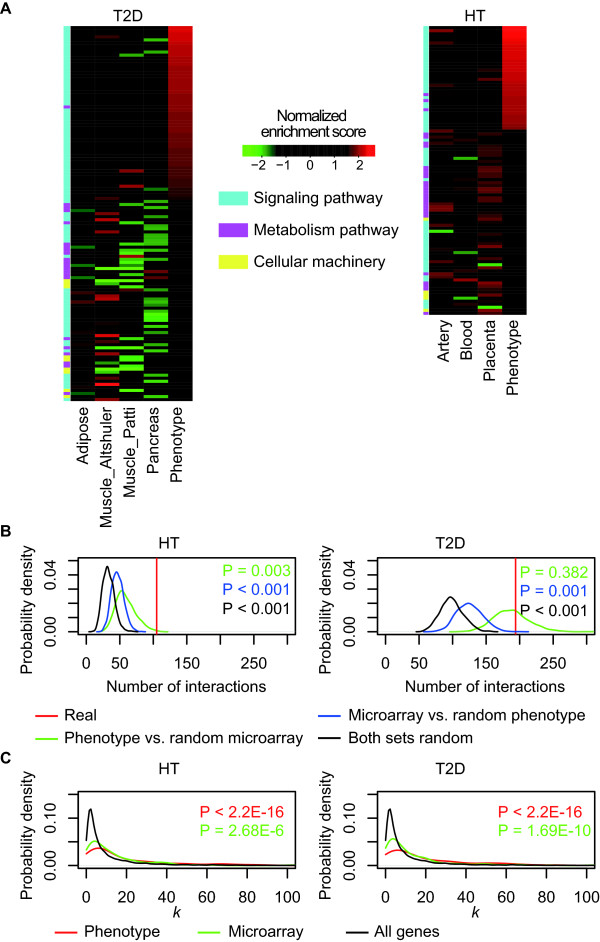
Pathways enriched among genes with high HT or T2D phenotype probabilities or differentially expressed genes. (A) Enriched pathways are listed according to their HT and T2D phenotype probabilities. The color in the heat plot indicates the normalized enrichment score given by the GSEA program. A black cell indicates that the pathway is not significantly changed in the analysis. For microarray expression analysis, the significantly up-regulated and down-regulated pathways are colored red and green, respectively. (B) Number of links between genes with high phenotype probabilities (> 95% specificity as determined in Fig. 4.) and those differentially expressed (RankProd pfp < 0.01) and its significance determined by Monte Carlo simulations. The red line indicates the number of interactions between the genes that have high phenotype probabilities (gene set A) and the genes only differentially expressed in various tissues combined (gene set B) as detected by microarray experiments. The black, blue or green curves indicate the probability density distributions of the number of links if genes in both set A and set B, either A (blue curve) or B (green curve) are replaced by randomly selected genes. Empirical P values are labeled on each graph. (C) Distribution of interaction degree k of high disease phenotype probability (> 95% specificity) genes (red curve), differentially expressed genes (green curve) and all genes in the interactome network (black curve). The Wilcoxon rank test P values of increase in k compared to the background 'all genes' are indicated for each gene set.